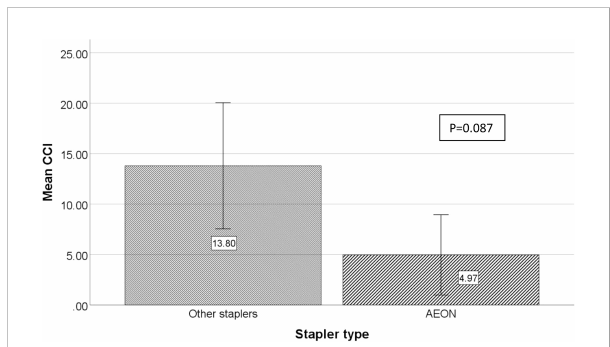
FIGURE 3 Comparison of mean comprehensive complication (CCI) index between AEON and other staplers used for pancreatic transection. The mean CCI when AEON was used was 4.97, increasing to 13.80 when other instrument were used (p =